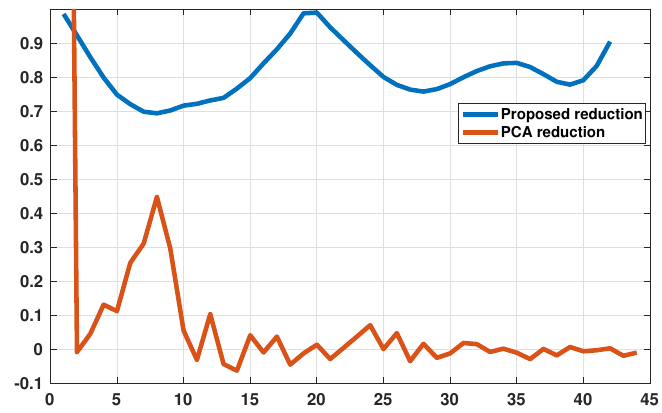
Figure 8. The spectral behaviour of principal component analysis (PCA) based band reduction and proposed ( Isos-bestic ) band reduction